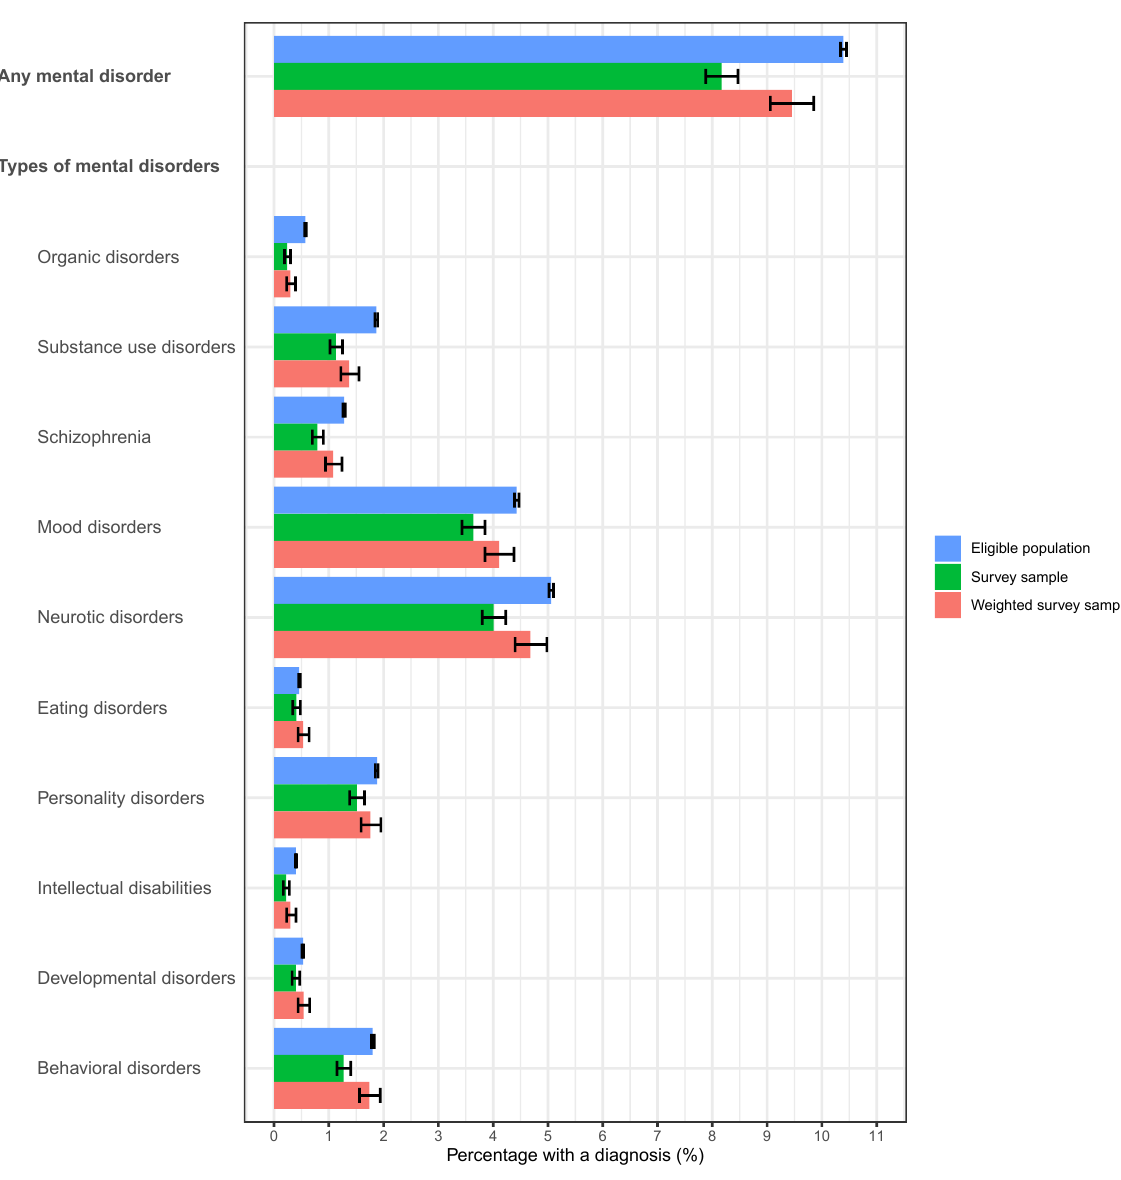
Figure 1: Prevalence of mental disorder diagnoses between all those eligible for the 2017 Central Denmark Region How are you? survey and the survey participants (before and after weights were